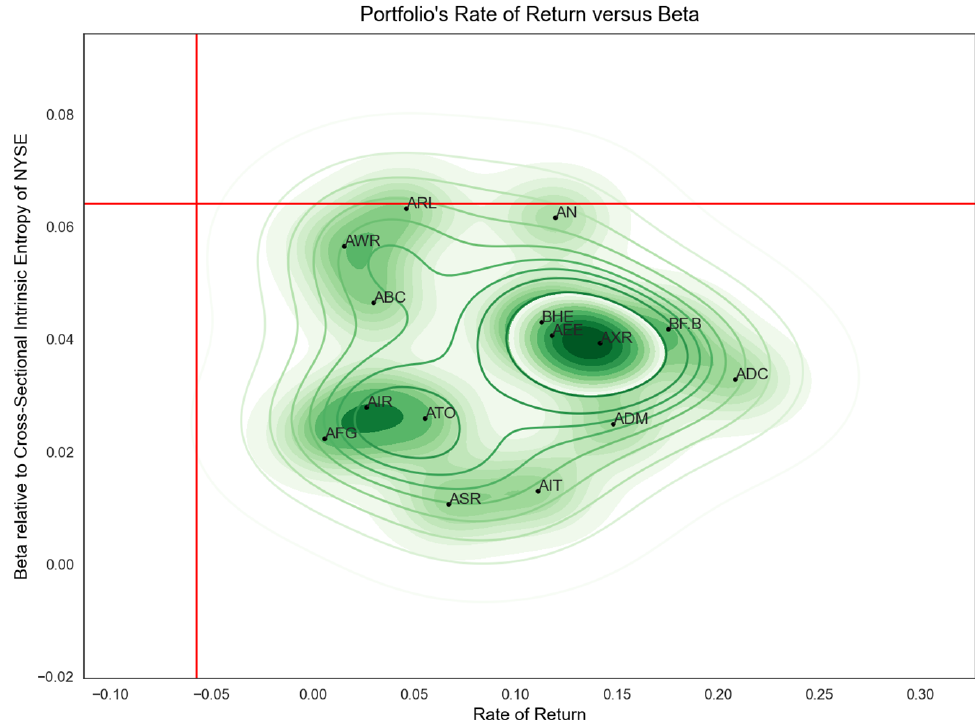
Figure 1. A set of 15 NYSE symbols that outperformed the S&P500 index in terms of rate of return without being exposed to higher risk (125-day trading interval, from 1 March 2022 to 26 August 2022) .